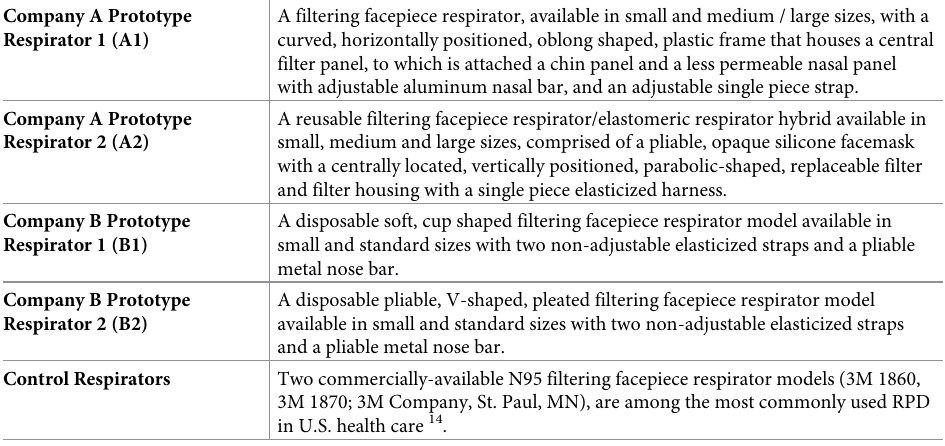
Table 2. Respiratory protective devices evaluated a